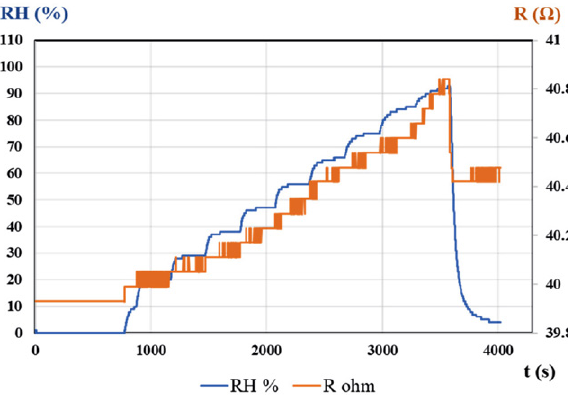
Figure 5. The RH response of the oxidized SWCNHs-based sensor in humid nitrogen (red curve) vs. the RH response of the Sensirion RH sensor (blue curve)